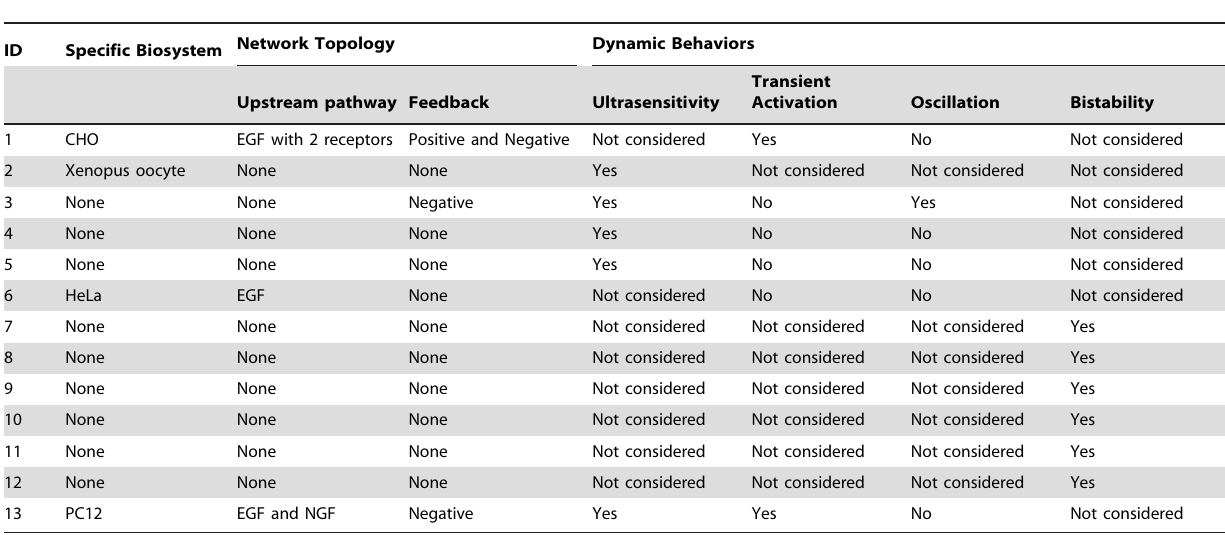
Table 1. A summary of previously reported MAPK models.